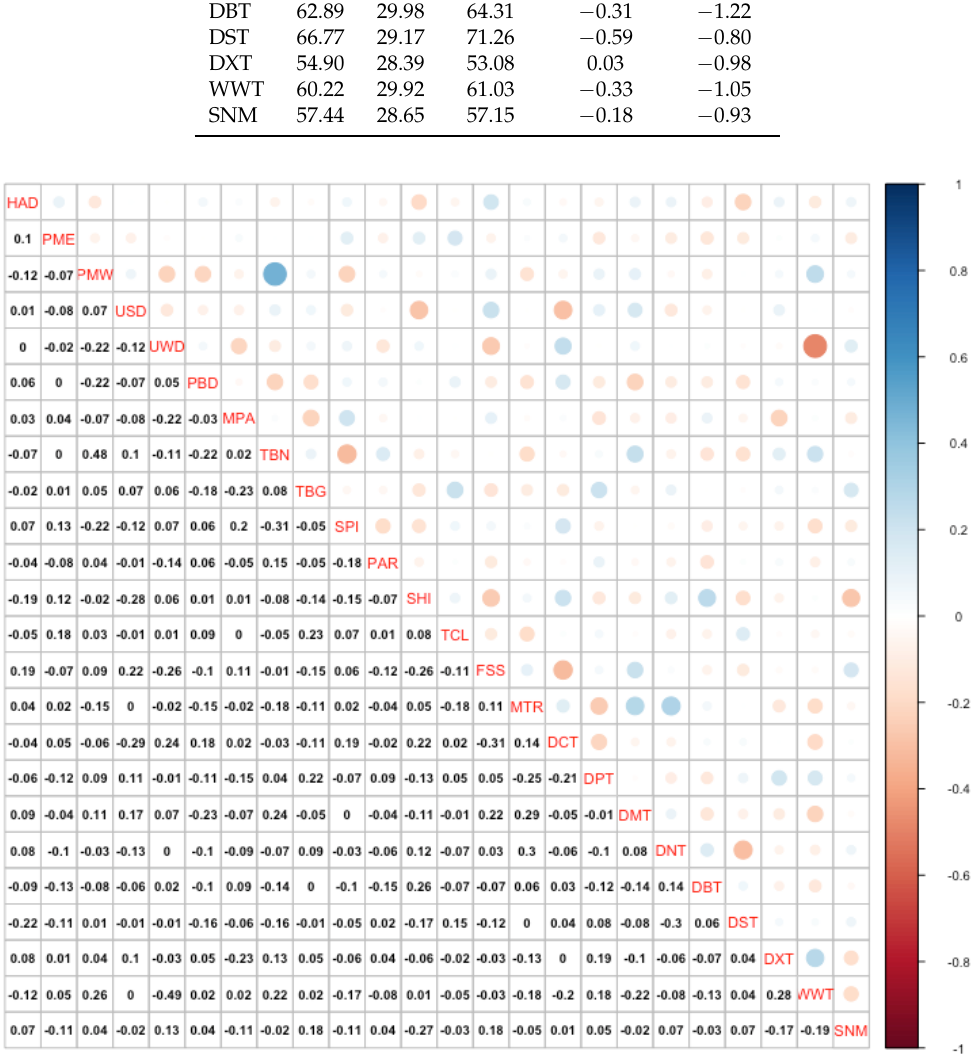
Figure 1. Correlation coefficients for the environmental